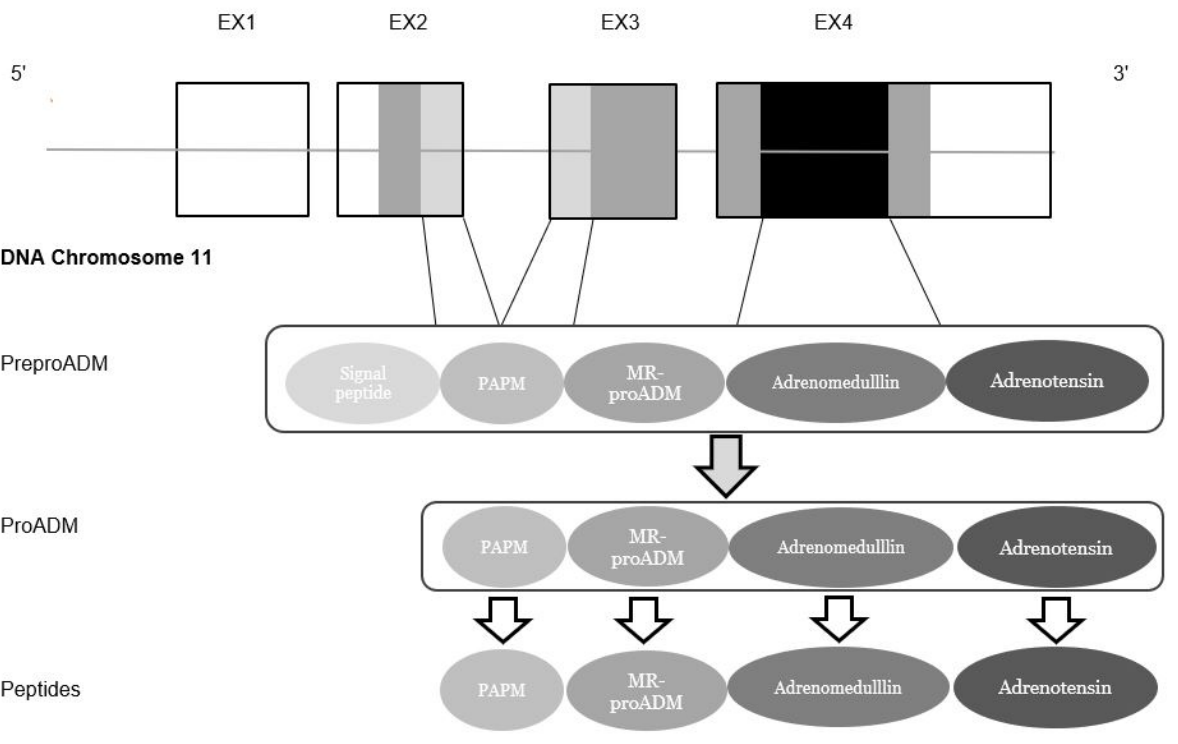
Fig. 1 - Schematic representation of the proadrenomedullin (proADM) gene [2] . DNA=deoxyribonucleic acid; MR-proADM=middle fragment of proadrenomedullin; PAMP=proadrenomedullin N-terminal 20